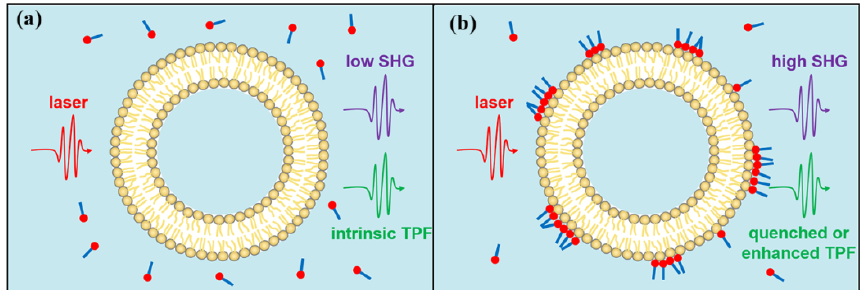
Figure 1. Illustration of the SHG and TPF analyses. ( a ) Lipids with interfacial symmetry radiate low SHG. Free probing molecules in the solutions radiate intrinsic TPF. ( b ) Aggregated probing molecules on lipids radiate quenched or enhanced TPF. Lipids with local interface asymmetry radiate high SHG. Be noted that the vesicle as a whole is symmetric with an inversion center. However, because of the different speeds for the excitation laser and generated SHG signal in the vesicles, the scattered SHG signal from different part of the vesicles interference with each other and emit detectable SHG for relatively large sized vesicles [22,47].